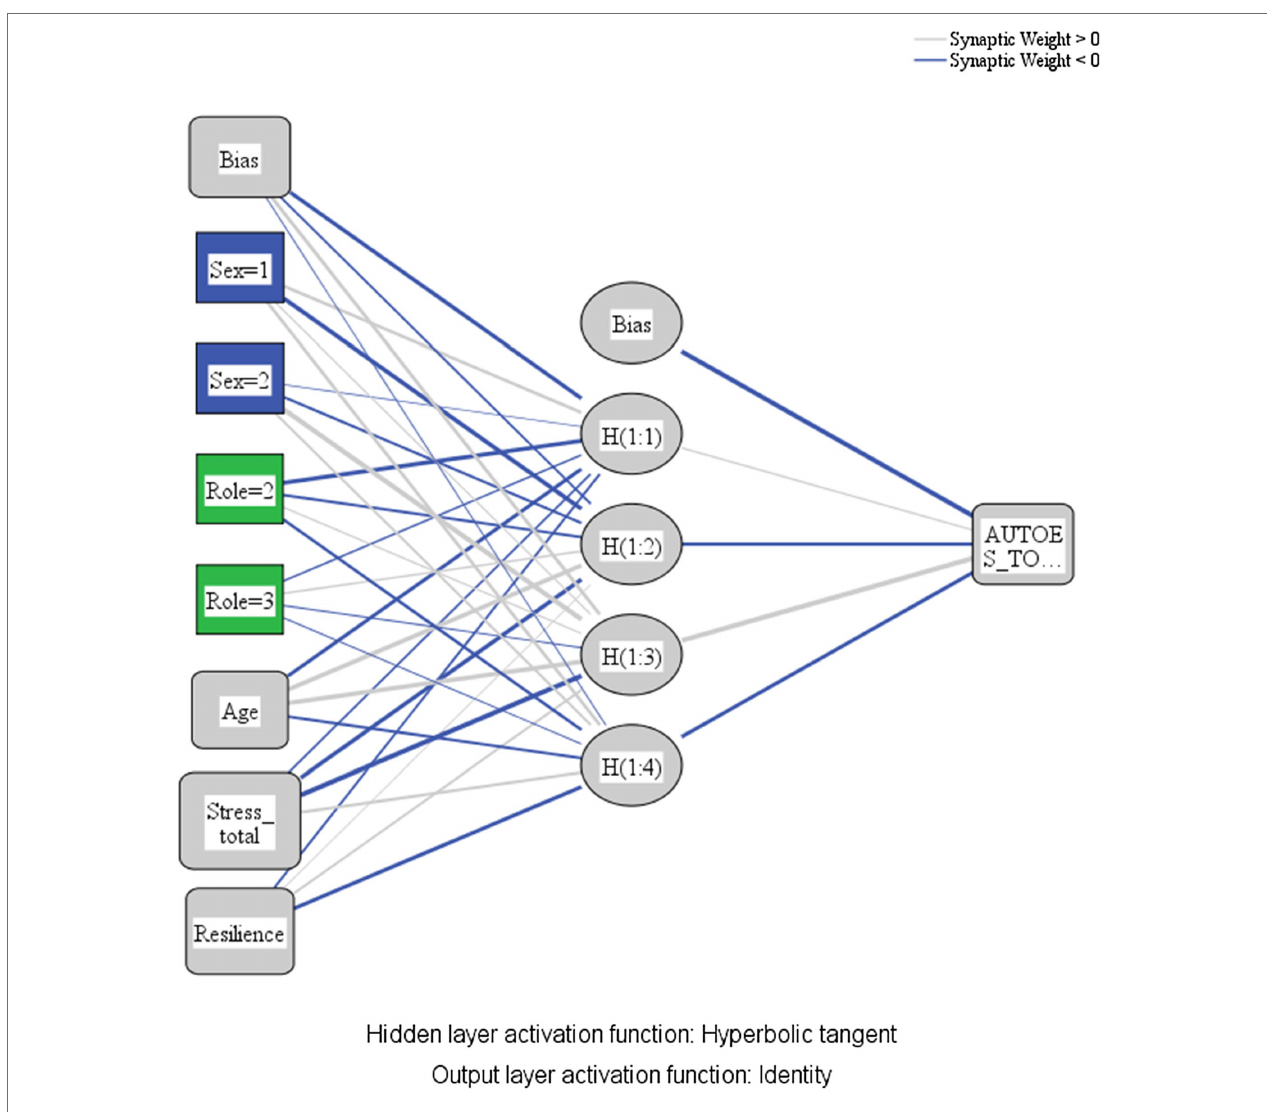
FIGURE 1 | Artificial neural network. Sex = 1: Female; Sex = 2: Male; Role = 2: Student; Role = 3: Teacher; Stress_total: Total score of perceived stress; and AUTOES_TO.: Total score in self-esteem. Source: Own